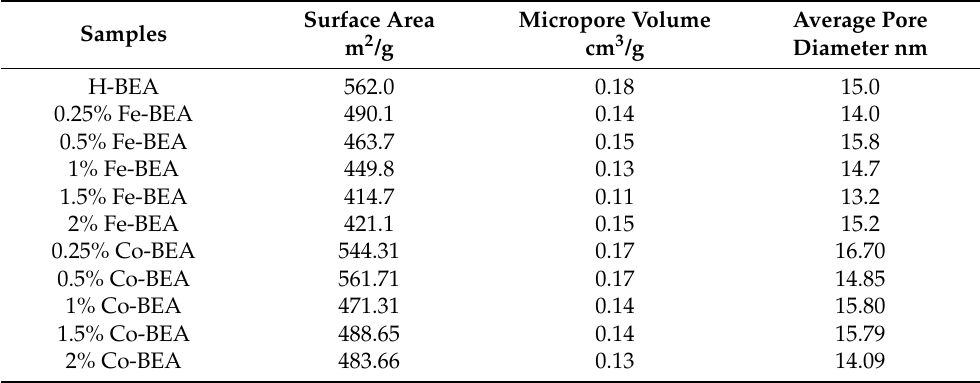
Table 1. Textural properties of H-BEA, Fe-BEA, and Co-BEA. Samples